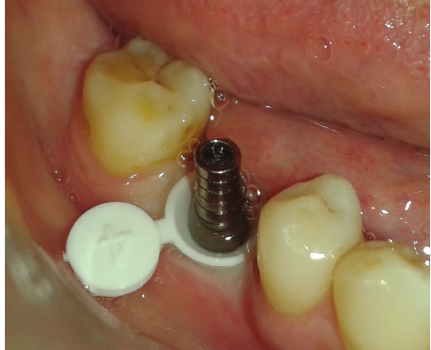
Figure 5: Abutment along with G-cuff.